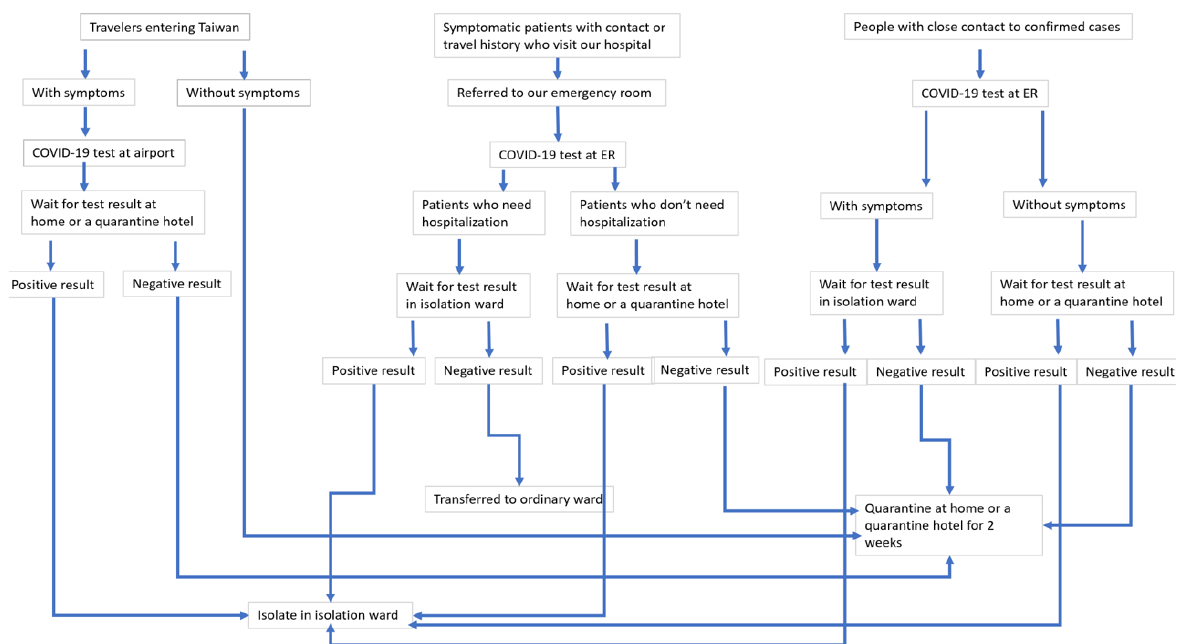
Figure 1. Flow diagram of COVID-19 screening, hospitalization, and home quarantine for travelers entering Taiwan, symptomatic patients who visited our emergency room, and people with close contact with confirmed cases.